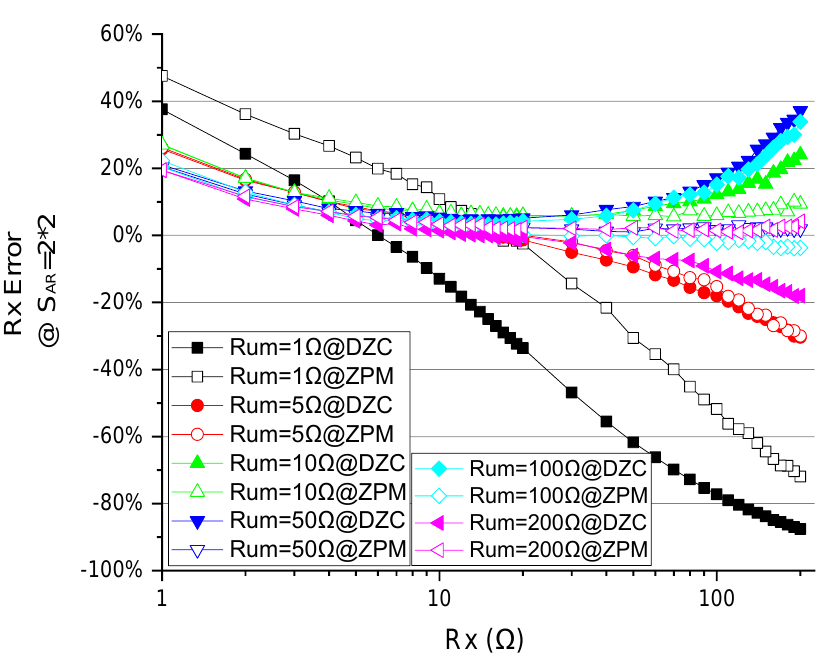
Figure 9. The effect of R x on measurement error of different R um when S AR = 2 × 2 in DZCM and ZPM (EXP B).